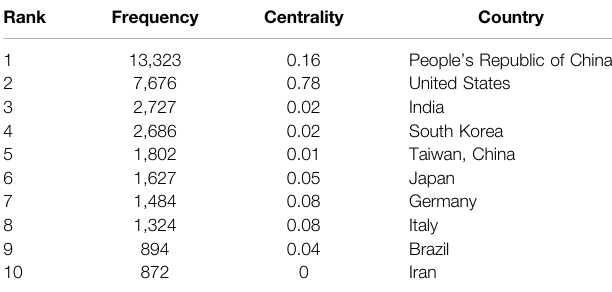
TABLE 3 | List of national or regional collaborative network for anticancer natural